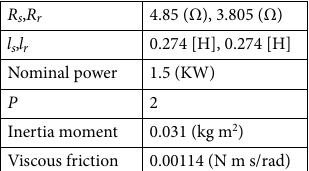
Table 3. Induction machine characteristics.